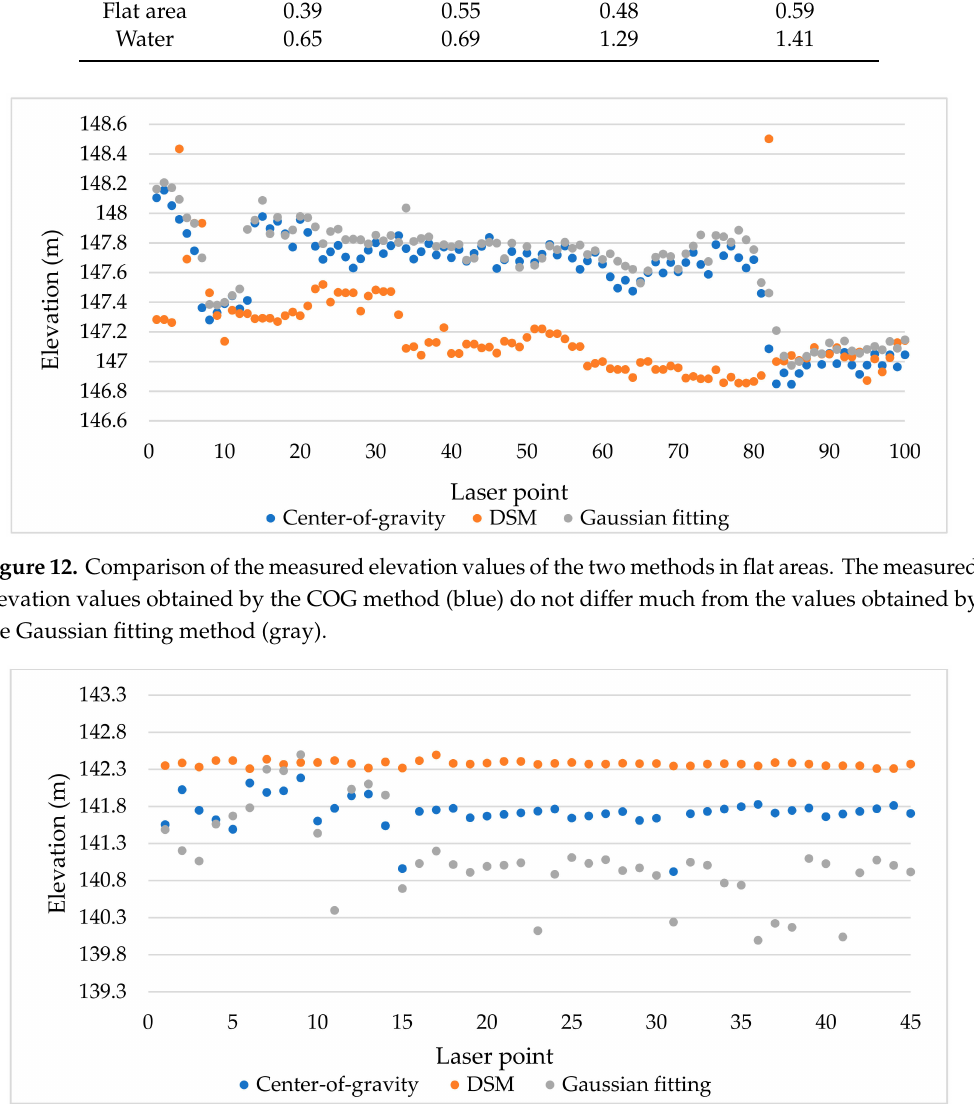
Figure 13. Comparison of the measured elevation values of the two methods in water areas. The measured elevation values obtained by the COG method (blue) are significantly higher than the values obtained by the Gaussian fitting method